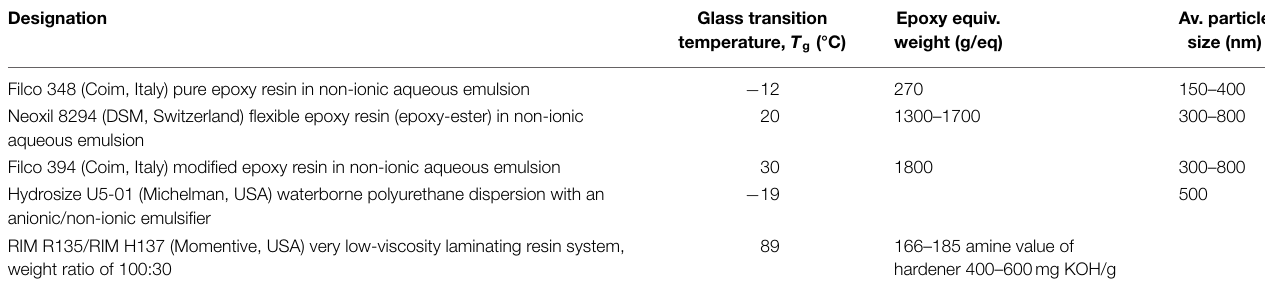
TABLE 2 | Characteristics of aqueous emulsions and epoxy resin used for surface modification of CNT fibers